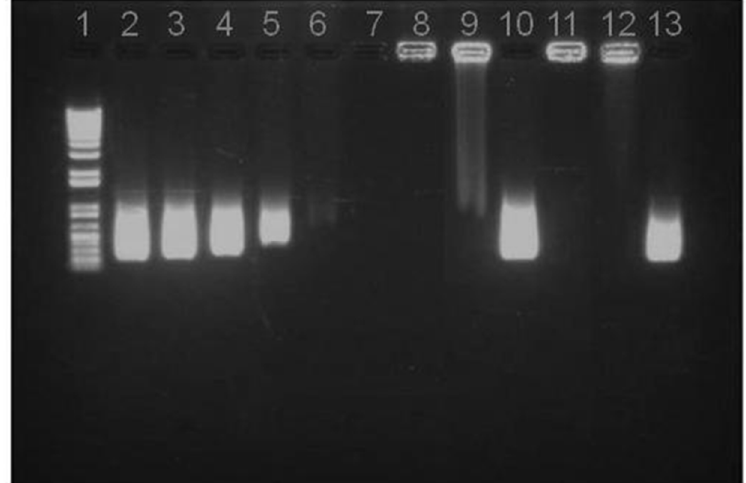
Figure 3. Agarose gel assay on pIC release from NP B (Chitosan/TPP/Poly (I:C)